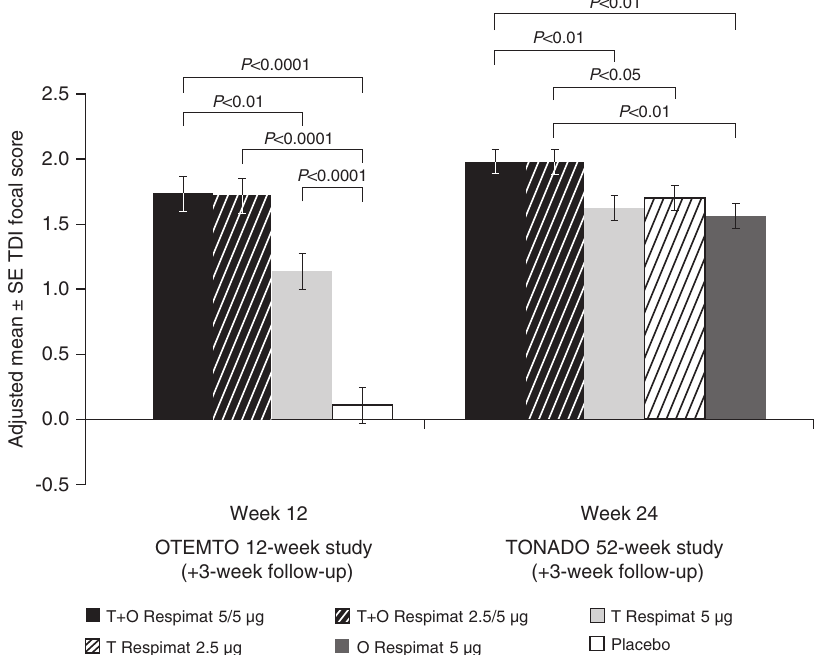
Fig. 2 Adjusted mean TDI focal score after 12 weeks of treatment (OTEMTO) or 24 weeks of treatment (TONADO). O, olodaterol; SE, standard error; T, tiotropium; TDI, transition dyspnoea